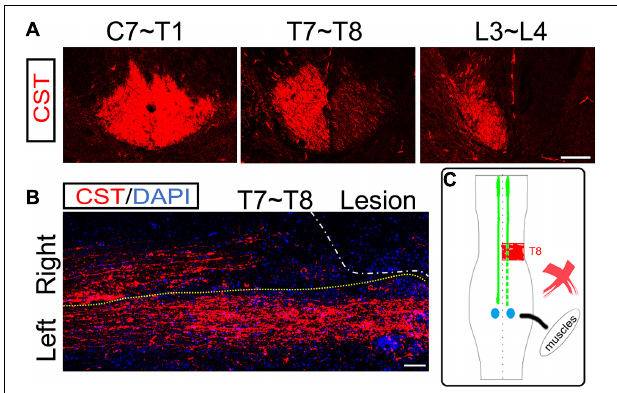
FIGURE 4 | No ipsilesional CST axons regeneration across the lesion site. (A) Transverse sections of hemisection model rats show the bilateral CSTs are mainly located in the deep dorsal funiculus. (B) The representative longitudinal sections contiguous to those with the maximum diameter show that the contralesional rostral CST axons descend through the hemisection injury site and arrive at the caudal segment. However, the ipsilesional CST fibers were terminated in the hemisection injury site, indicating no CST axonal regeneration. (C) The sketch map shows the CST regeneration contributing to the spontaneous locomotor recovery; however, this probability is also excluded in the hemisection model rats. n = 8 for CST tracing in hemisection model rats. Scale bar, 50 µ m. CST indicates the corticospinal